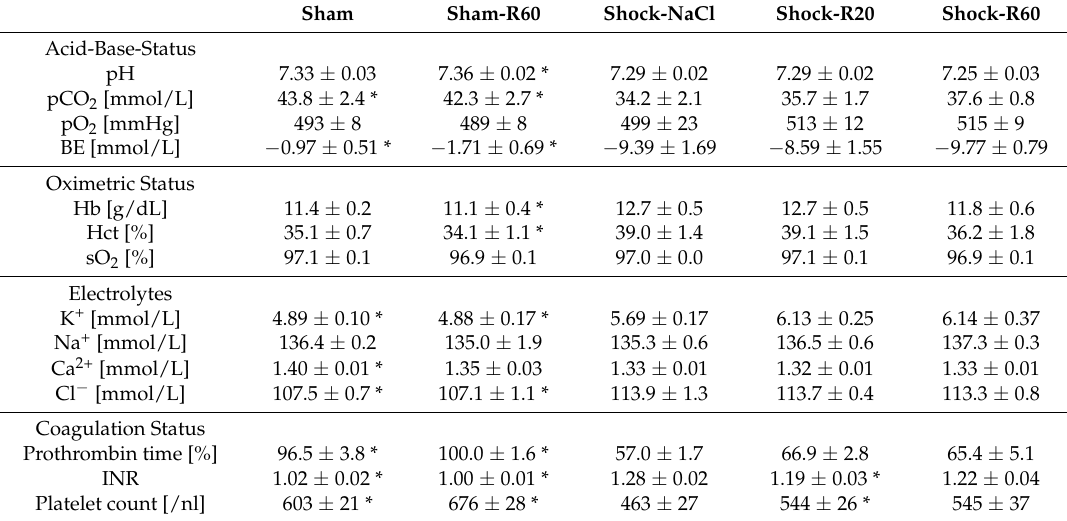
Table 1. Effect of continuous intravenous infusions of solvent-free low-dose resveratrol on parameters of blood gas analysis and coagulation subsequent to severe hemorrhagic shock in rats. Rats underwent severe hemorrhage (30 min shock induction, 60 min shock phase), then were resuscitated within 30 min with the withdrawn blood and lactated Ringer’s equal to twice the volume of the withdrawn blood (30 min) in the absence (Shock-NaCl) or presence of resveratrol (20 or 60 µ g/kg × h until the end of the experiment; Shock-R20, Shock-R60) and observed for a further 150 min. Sham animals received either pure 0.9% NaCl solution (Sham-NaCl) or the higher resveratrol dose (Sham-R60). Parameters of blood gas analysis (pH; oxygen and carbon dioxide partial pressure, pO 2 , pCO 2 ; base excess, BE; hemoglobin, Hb; hematocrit, Hct; oxygen saturation, sO 2 ), electrolytes (K + , Na + , Ca 2+ , Cl − ) and of coagulation (prothrombin time; international normalized ratio, INR; platelets count) were determined from final arterial blood samples as obtained immediately before rats were sacrificed. Shown are mean values ± SEM ( n = 8 animals per group). * p < 0.05 (vs. Shock-NaCl). Sham Sham-R60 Shock-NaCl Shock-R20